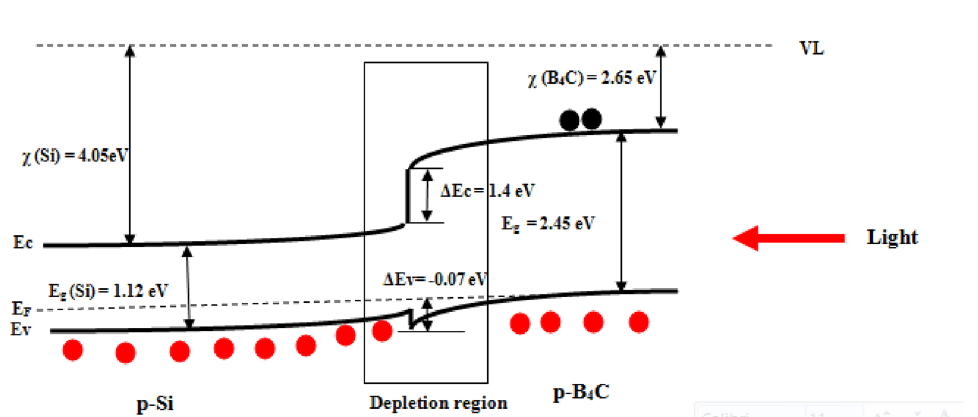
Figure 19. Illuminated energy band diagram of p-B 4 C/p-Si heterojunction photodetector prepared at 500 laser